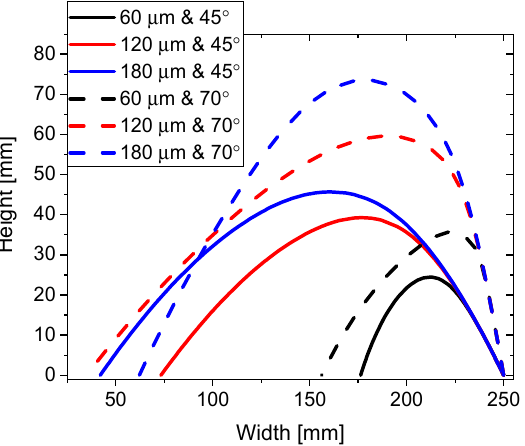
Figure 12. Normalized velocity profiles for the modified design with 6 mm nozzle inlet diameter. ( Left ): Velocity magnitude in the center plane normalized with the maximum velocity of 2.61 m/s. ( Right ): Velocity magnitude in the vertical plane normalized with the maximum velocity of 2.59 m/s.